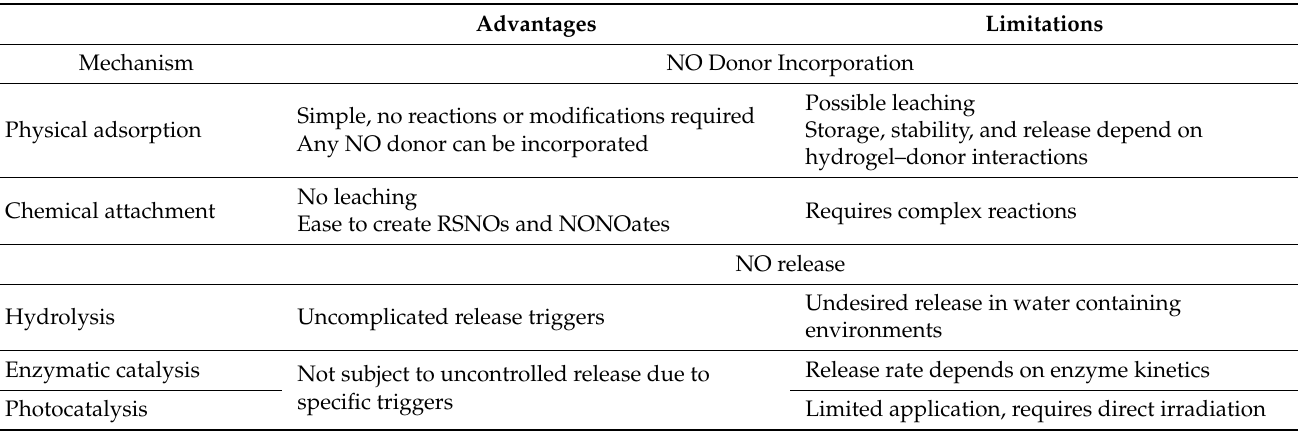
Table 5. Summary of advantages and disadvantages of NO donor incorporation in hydrogels and NO release mechanisms.